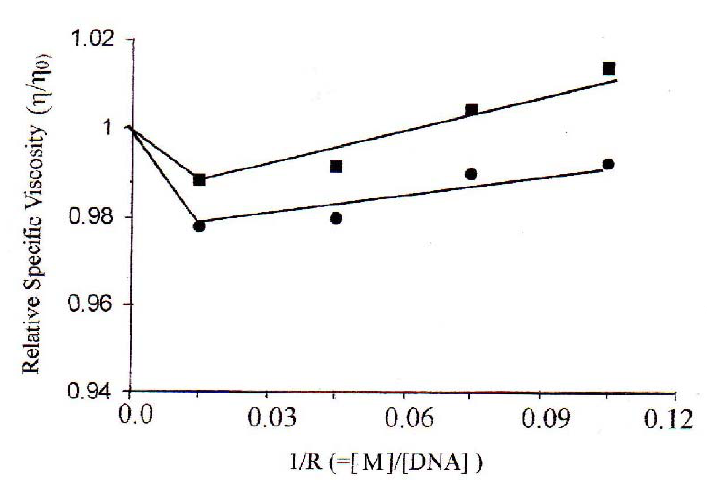
• ), and complex 5 ( (cid:2) ) on the relative